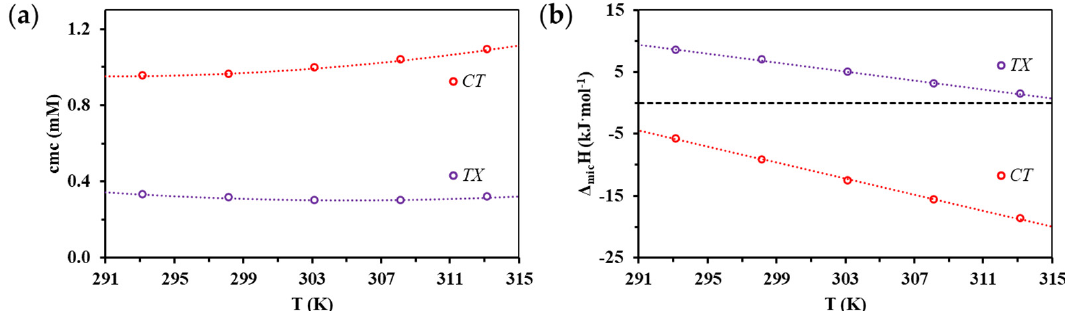
Figure 3. ( a ) Changes in cmc of CT and TX surfactants determined by ITC as a function of temperature; ( b ) Enthalpy change of micellization of CT and TX surfactants as a function of temperature.